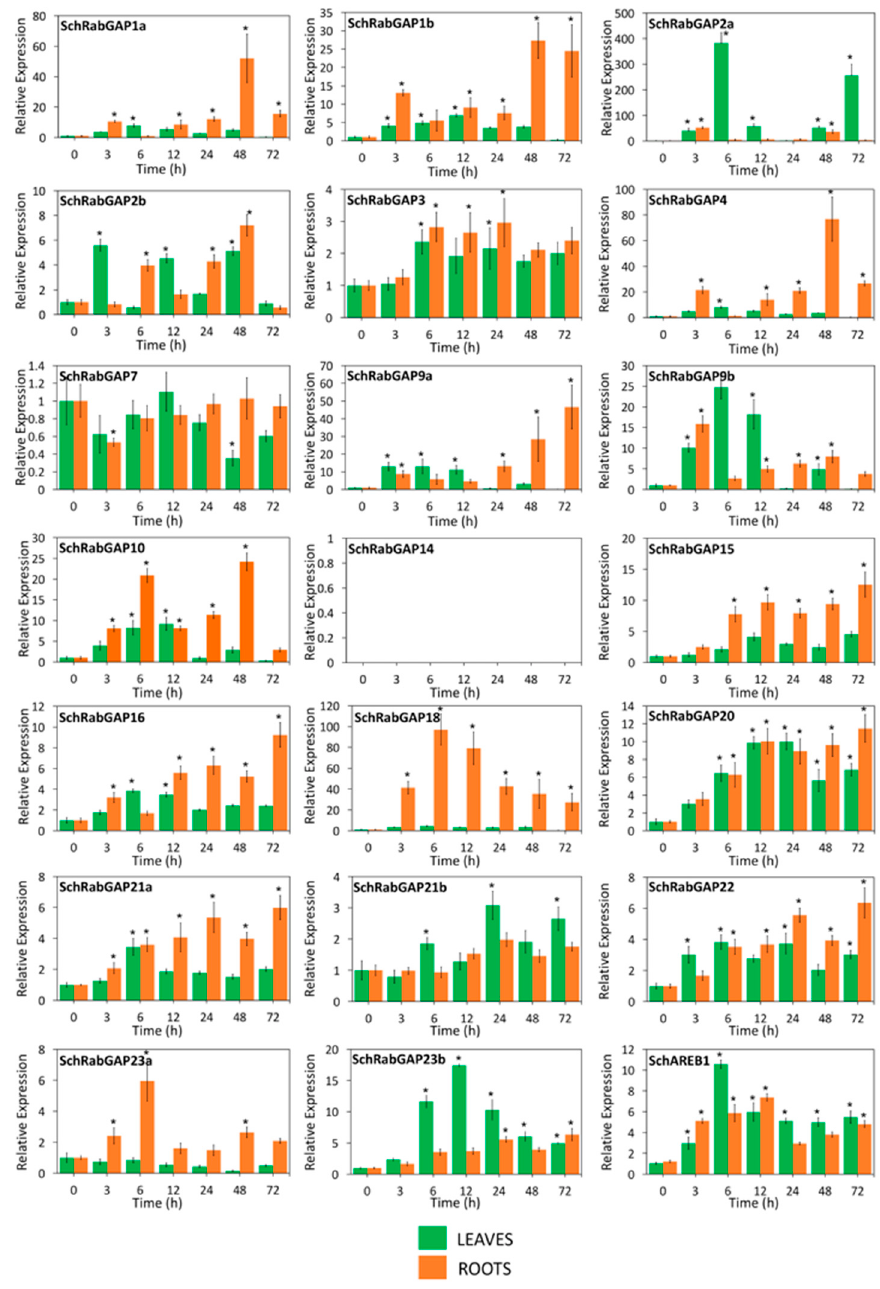
Figure 9. Spatio-temporal expression patterns of RabGAP genes of S. chilense exposed to salt stress. Relative levels of RabGAP gene transcripts in roots (orange bar) and leaves (green bar) of 10–12 weeks old S. chilense plants were determined at 0, 3, 6, 12, 24, 48, and 72 h after stress initiation with 300 mM NaCl. The relative levels of the salt-stress marker gene (SchAREB1) were measured. In SlRabGAP14, transcripts were not detected. Columns and error bars represent the mean and standard deviation for three biological and three technical replicates. * p -value < 0.05.